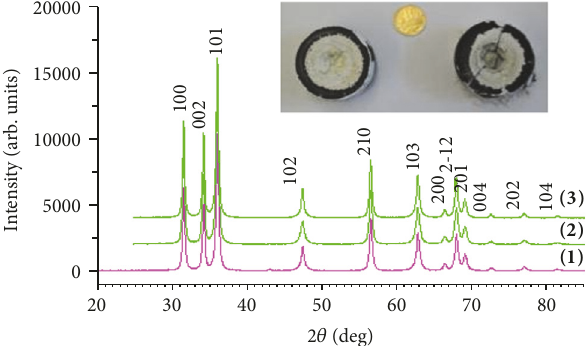
∗ The sample number 2 is produced by evaporation of the target from ZnO with the air pressure of 20Pa. ∗∗ Average concentration of 𝑥 C from three sites of each sample is given. ∗∗∗ Further , this numbering of NPs samples is used.